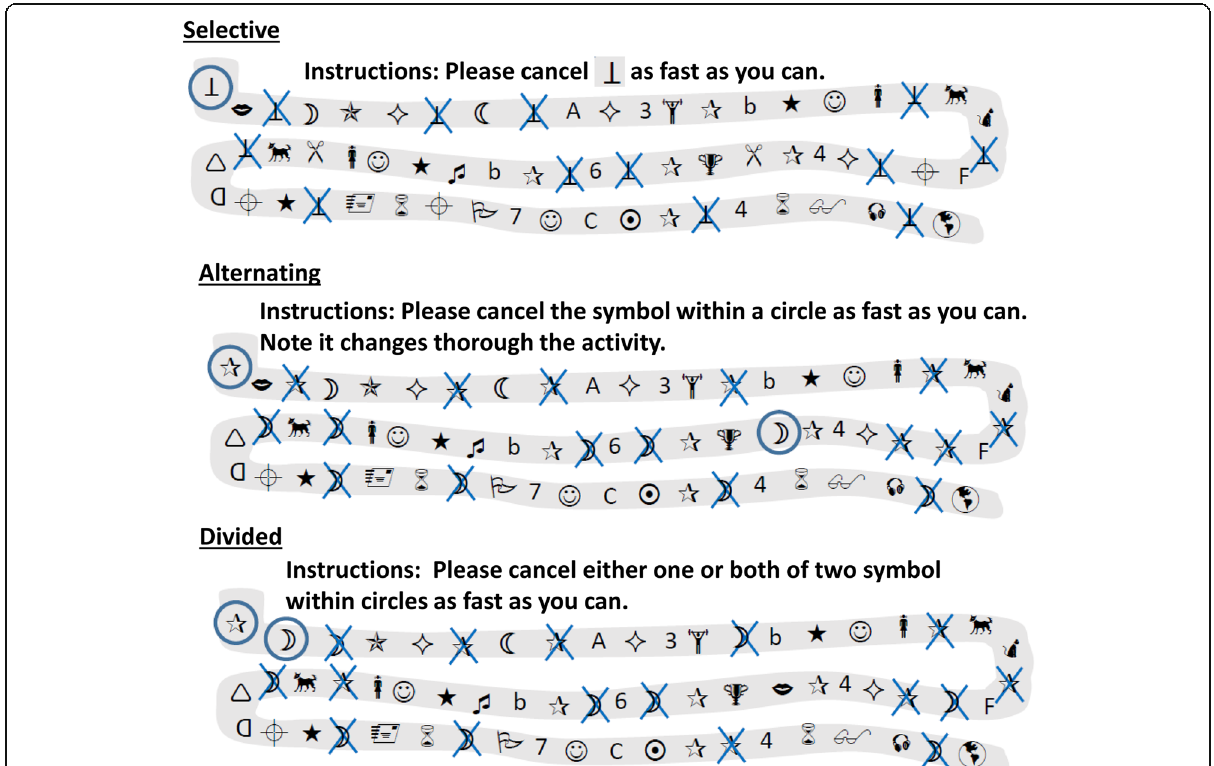
Fig. 2 Cancelation tasks for attentional measure (adapted stimuli are shown because of copyright restrictions)